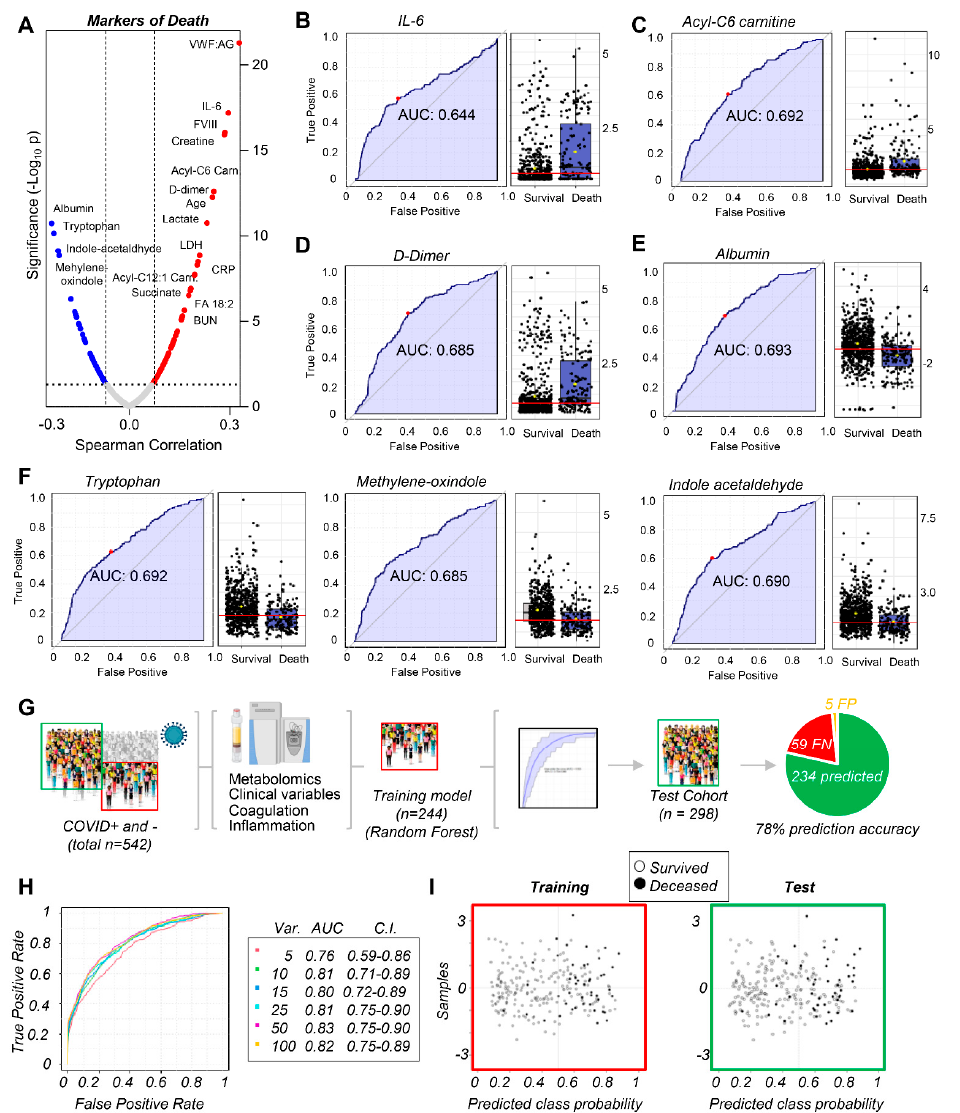
Figure 4. Markers of mortality in hospitalized patients, including COVID-19 patients. In ( A ), clinical and metabolic markers of mortality were ranked from Spearman correlation analyses (y axes indicate − log10 of p -values). Because mortality is a non-continuous variable, additional univariate ( B – F ) and multivariate ( G ) biomarker analyses were performed to calculate ROC curves and train machine learning algorithms (random forest in this figure, supporting vector machine in the Supplement) to predict mortality in hospitalized COVID-19 patients based on the top 10 clinical and metabolic variables ( H ), a model that yielded 78% prediction accuracy ( G – I ).